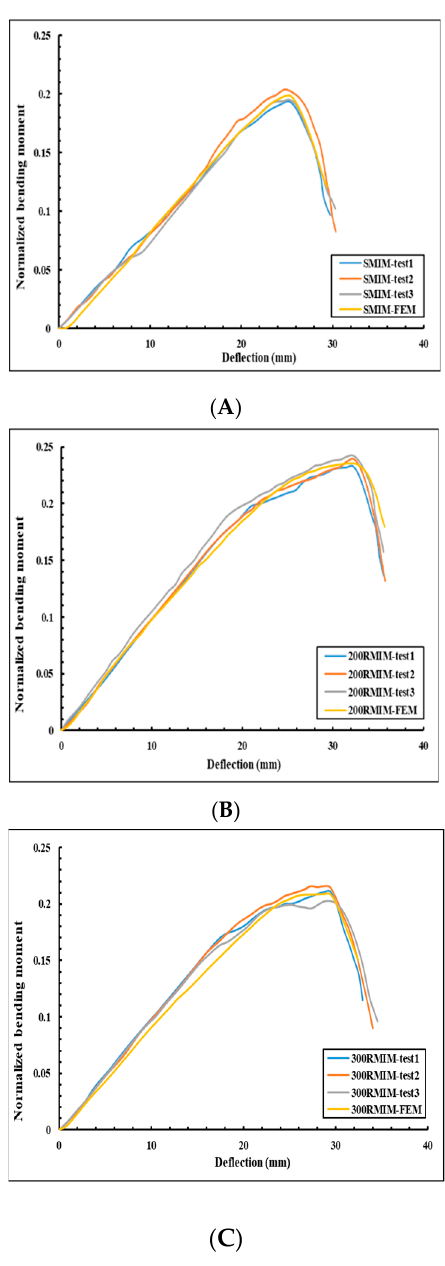
Figure 25. Finite element model and experimental curves for minor axis test set-up: ( A ) non-reinforced types; ( B ) 200 mm reinforced types; ( C ) 300 mm reinforced types.